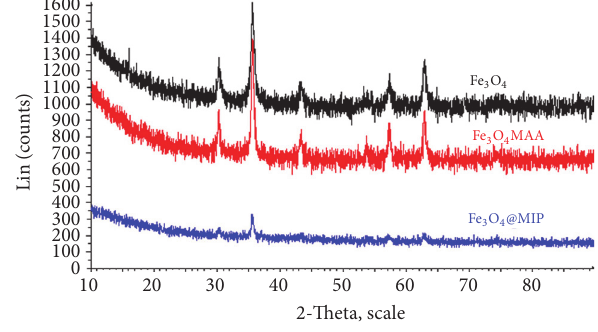
Figure 3: XRD of magnetic particles.